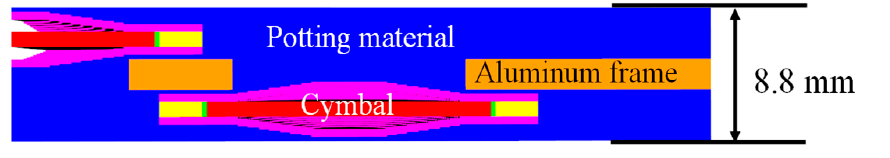
Figure 3. FEA model of the immersed cymbal array.